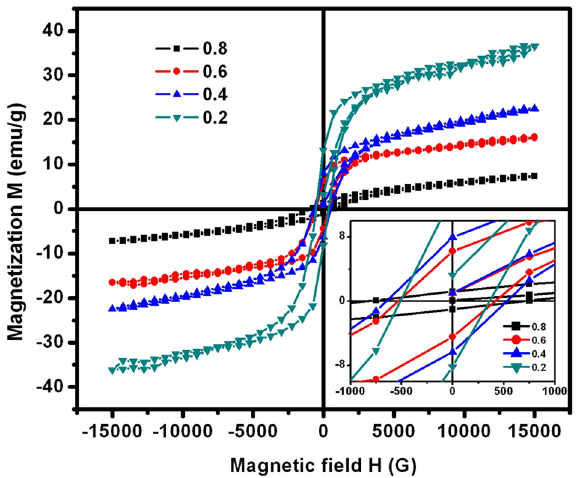
Figure 9. M-H loops of SLFO nanoparticles.